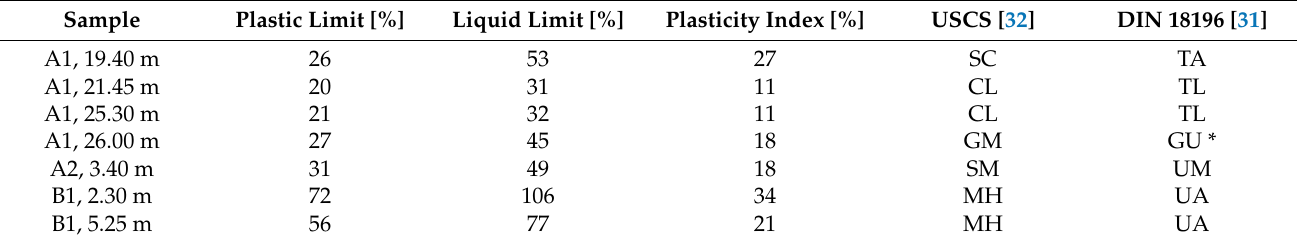
Table 3. Results of the Atterberg limits tests, showing sample numbers, plastic and liquid limits, plasticity indices as well as specifications according to the applied